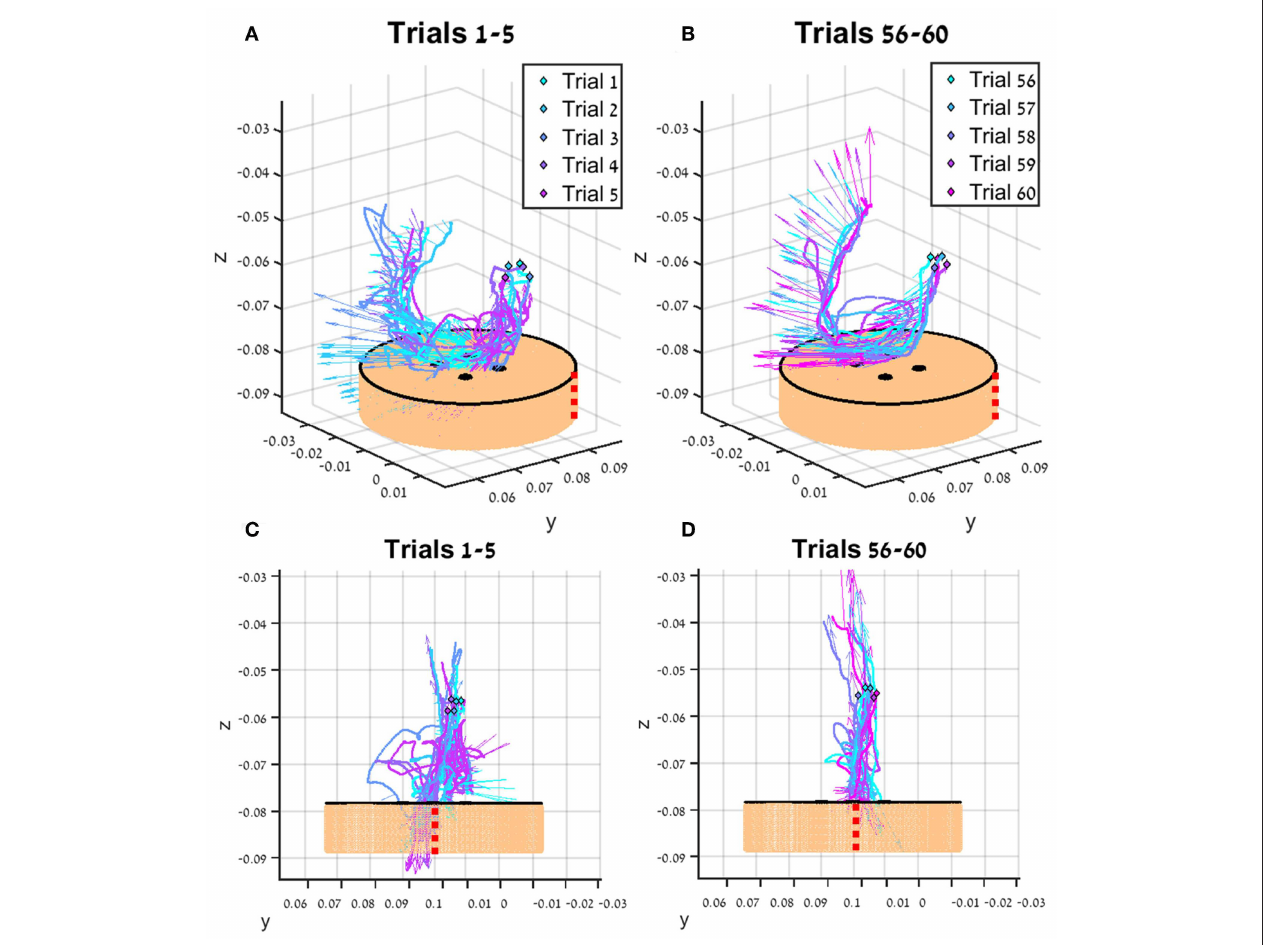
FIGURE 7 | An example of trajectories (lines) and tissue interaction forces (arrows) from the first 5 teleoperated trials (A) and last 5 trials (B) of participant from direct force (DF) feedback condition. The start of each trajectory is denoted by a diamond marker. Tissue interaction forces are represented by arrows, and each arrow represents the direction of the force at the specific sample together with the size of the force (length of the arrow). Different viewpoint of the same trajectories are presented in (C,D) . The skin-toned flat cylinder represents the mock tissue specimen at scale. Red dotted line is presented to orient the viewer in space.